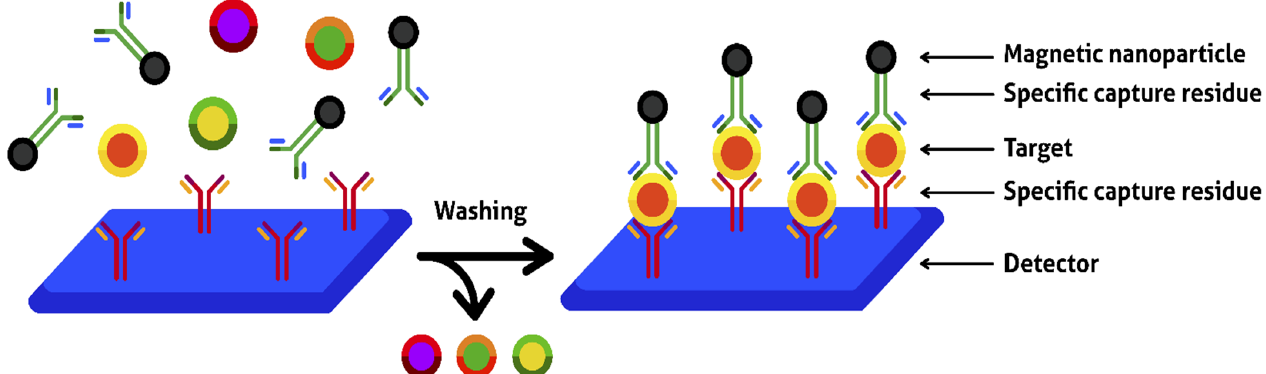
Figure 8. Schematic representation of the MNP sensing approach. MNPs form a stable complex with target and detector surfaces. The sorption on the surface is caused by a specific capture residue or a magnetic field. The red and yellow circle is the specific analyte.